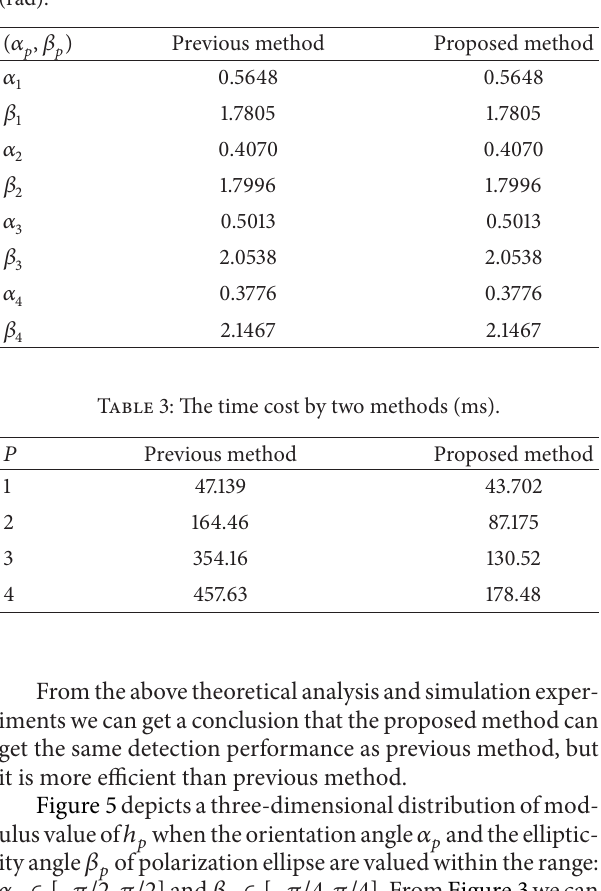
Table 4: The maximum fitness function values got by two methods in a special circumstance ( ×10 7